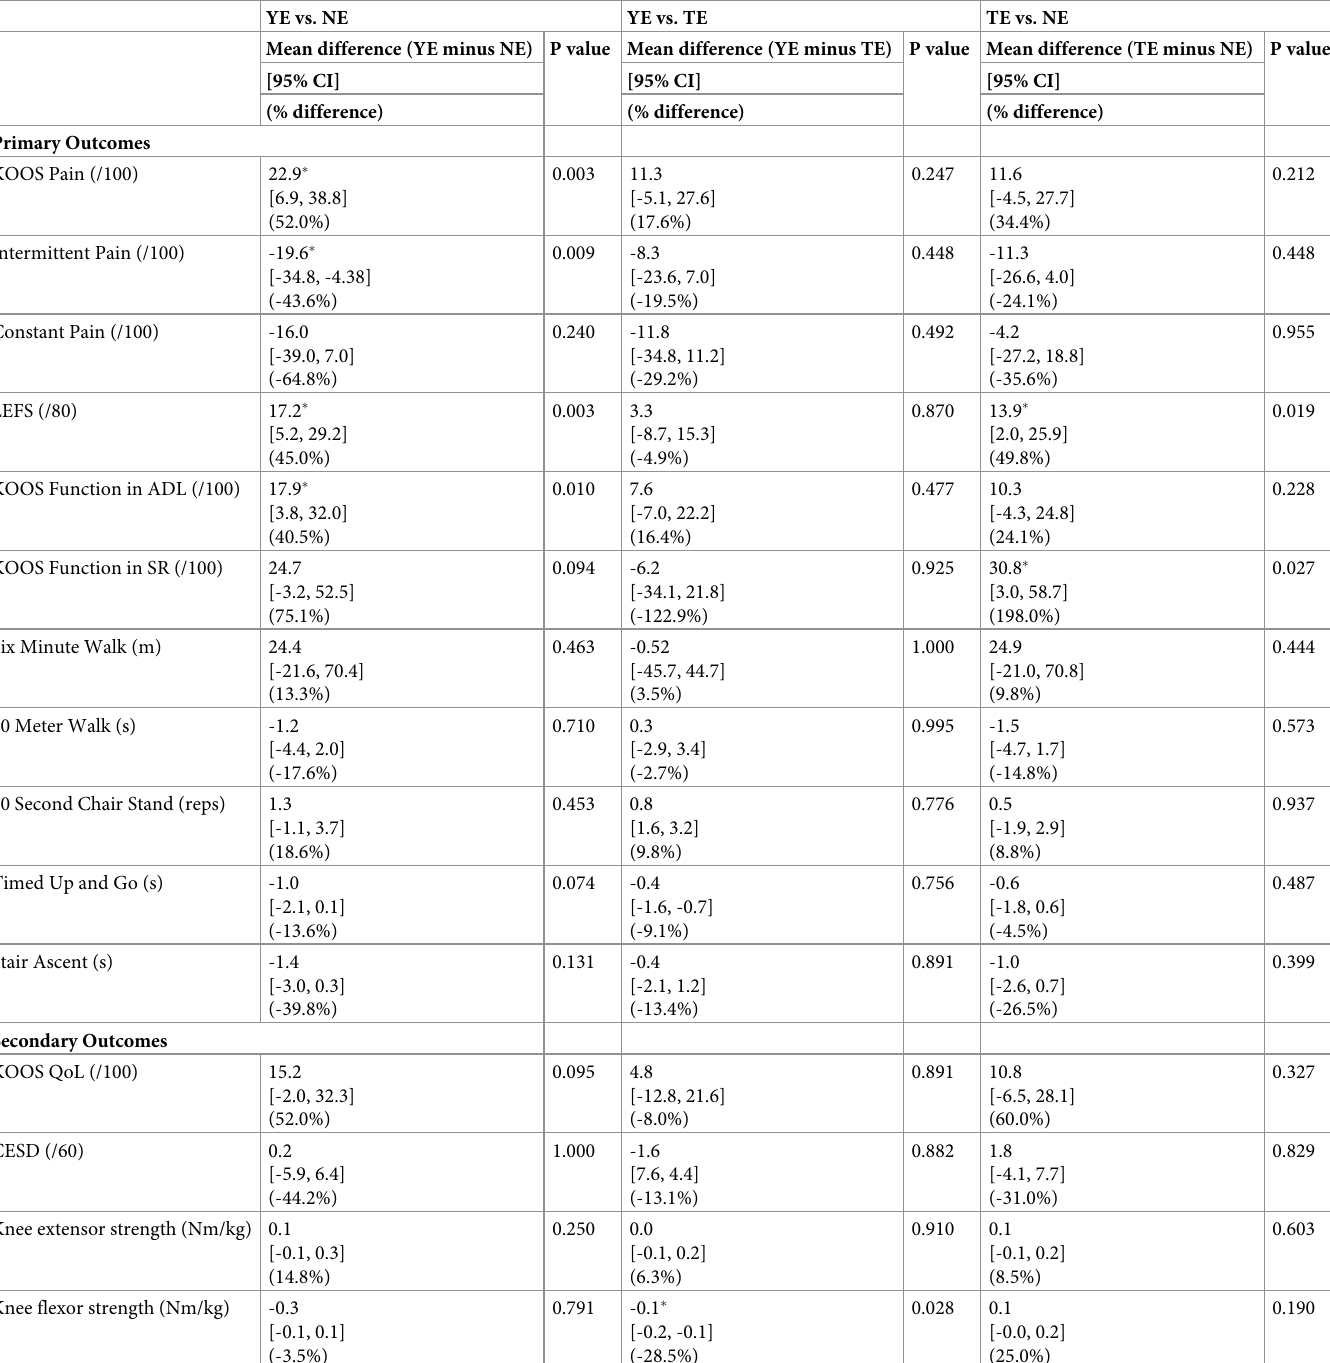
Table 2. Pairwise between-group mean differences and percent differences in outcome measures using analysis of covariance adjusting for baseline values. Percent differences were calculated as [follow-up minus baseline]/baseline. YE vs. NE YE vs. TE TE vs.